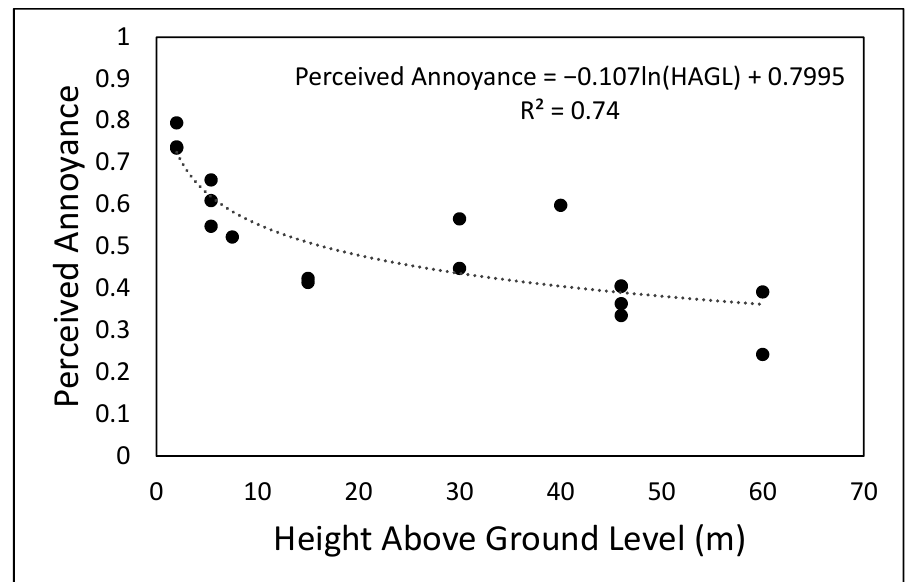
Figure 2 . Perceived annoyance vs. height above ground level of the unmanned aerial vehicles under investigation during flyover operation.